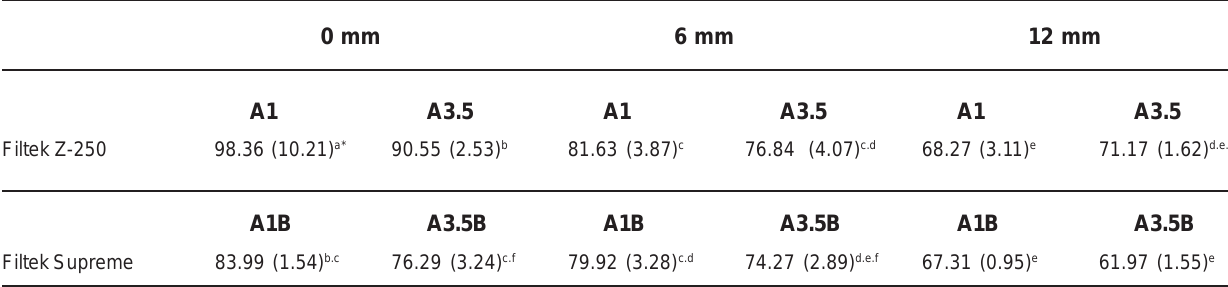
*Data are presented as mean (standard deviation), n=7. Groups with the same superscript letters are not significantly different (Tukey post hoc multiple comparison test; p>0.05).